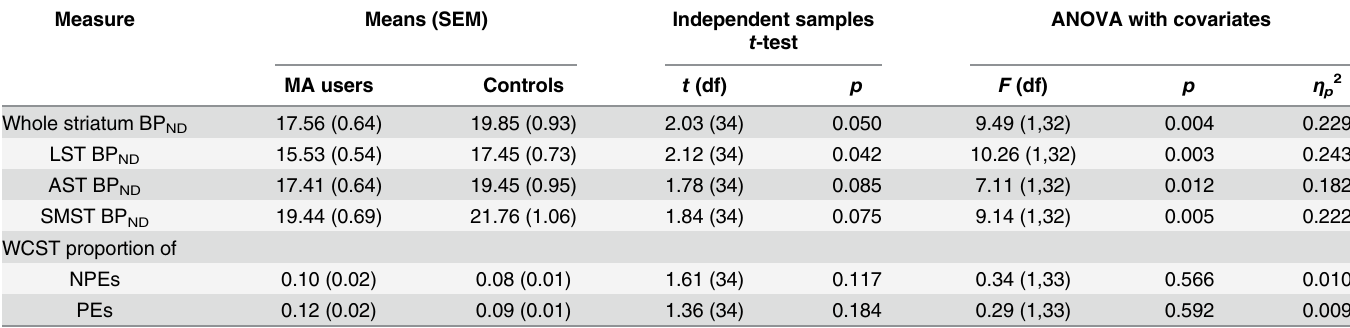
Table 2. Comparison of striatal BP ND and WCST performance between MA users and controls ( n = 18 each). Measure Means